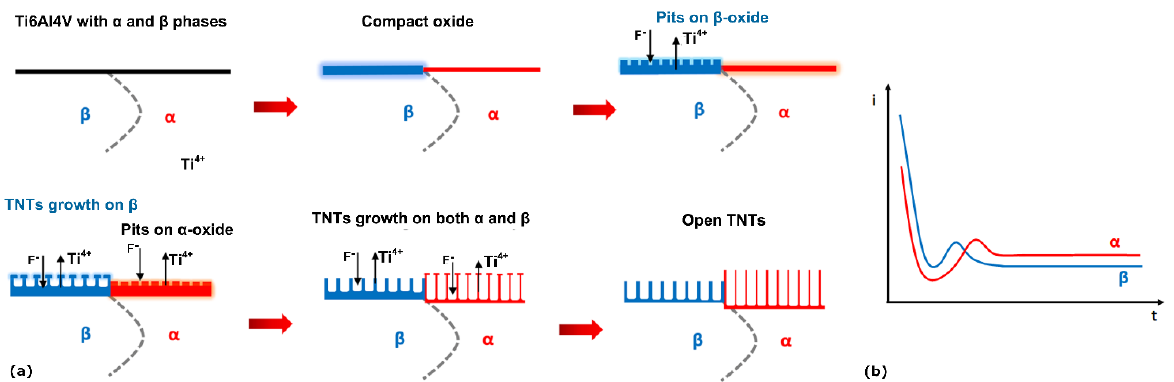
Figure 10. ( a ) Schematic representation of the different steps of growth of the anodic oxide layer in Ti6Al4V alloy. ( b ) Sug- gestion of the individual current density-time plot for each individual phase adapted from